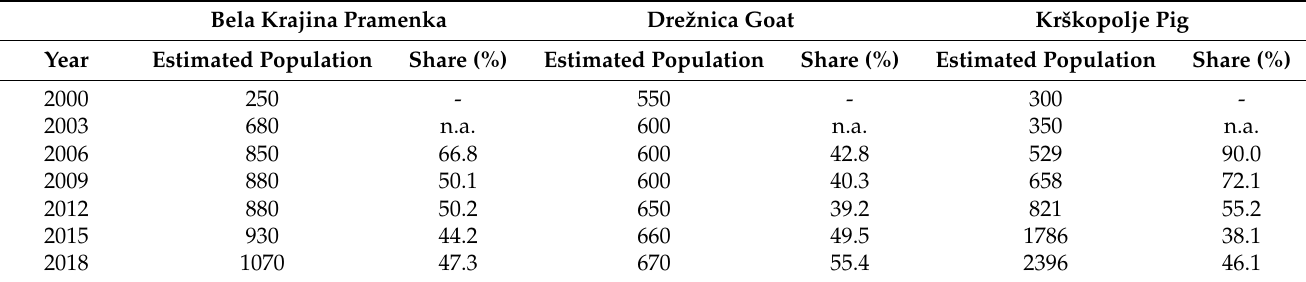
Table 2. Estimated population of local breeds and share of the population included in the Rural Development Plan [51,55]. Bela Krajina Pramenka Drežnica Goat Krškopolje Pig Year Estimated Population Share (%) Estimated Population Share (%) Estimated Population Share (%) 2000 250 - 550 - 300 - 2003 680 n.a. 600 n.a. 350 n.a. 2006 850 66.8 90.0 2009 880 50.1 600 72.1 2012 880 50.2 2015 930 44.2 49.5 2018 1070